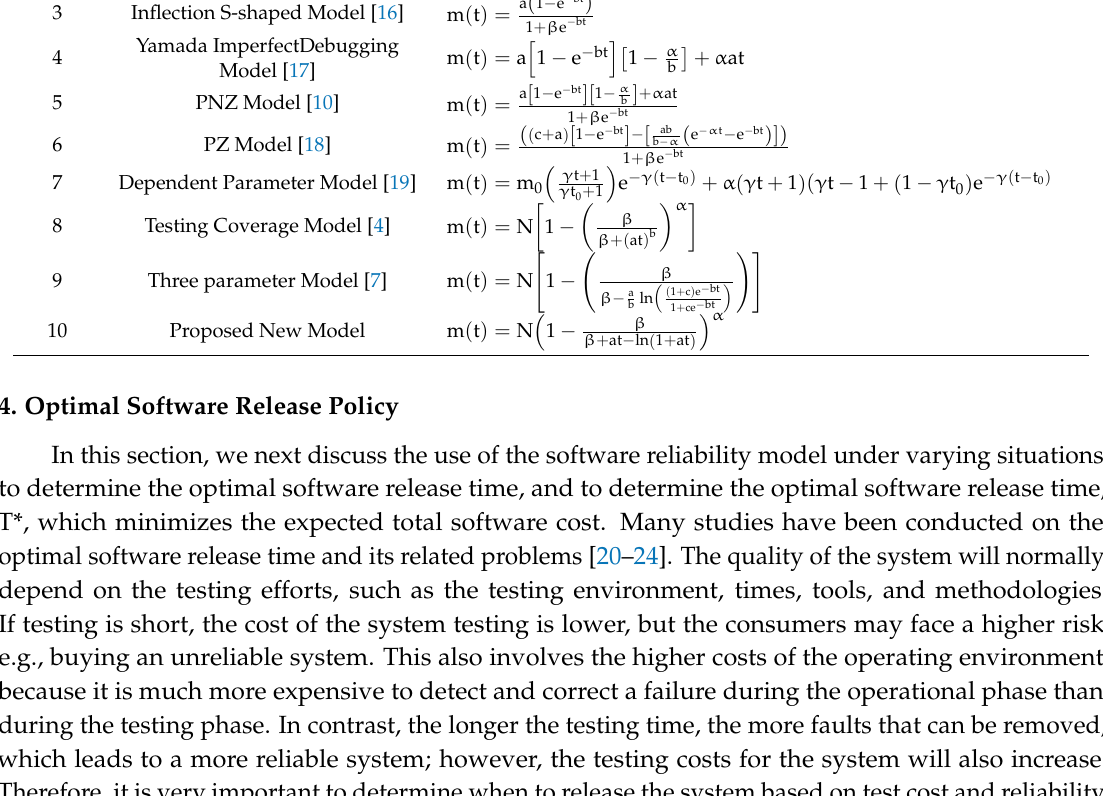
Table 1. NHPP software reliability models.